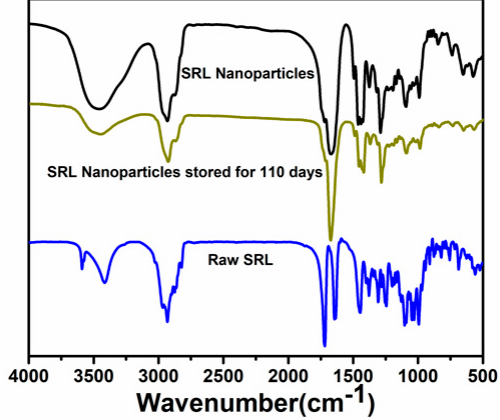
Figure 8. FT-IR spectra of raw SRL, SRL nanoparticles, and SRL nanoparticles stored for 110 days.